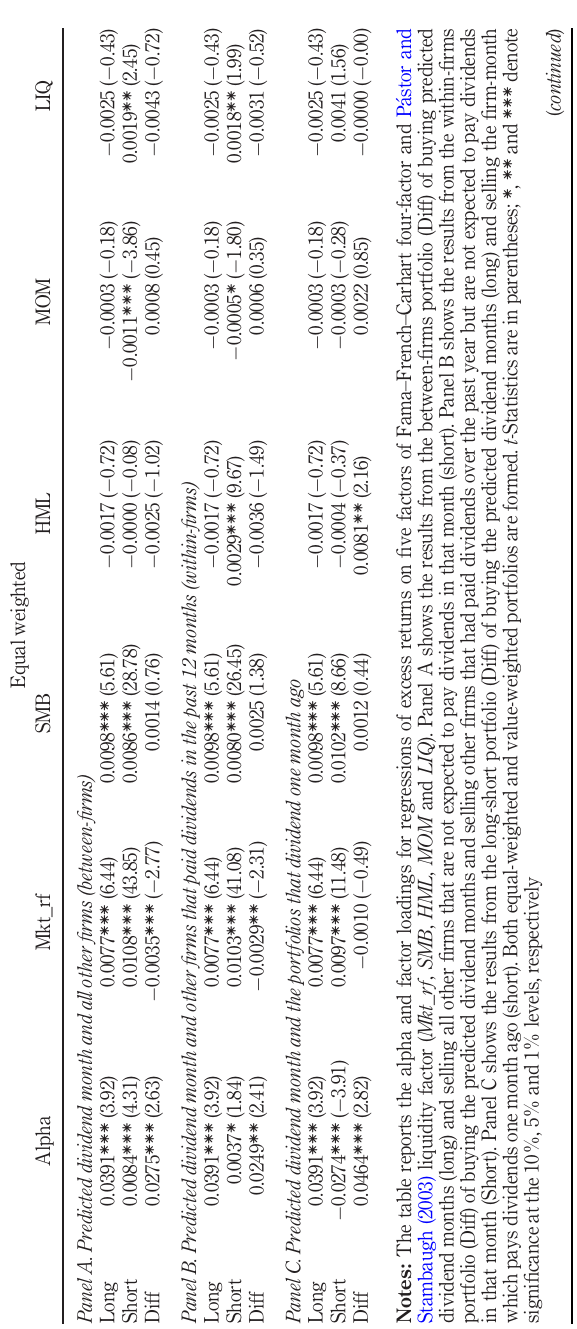
Table 6. Risk-adjusted